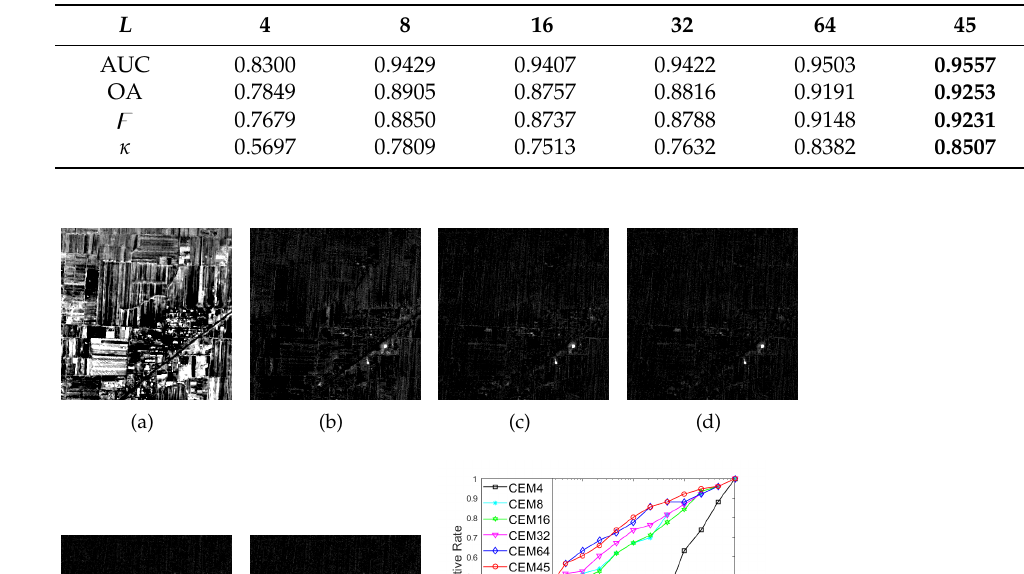
Table 3. The quantitative comparison for AUC, OA, F-score (denoted (cid:122) ), and Kappa coefficient (denoted κ ) with different L s for the Xi’an data. Bold numbers indicate the highest values in each row.